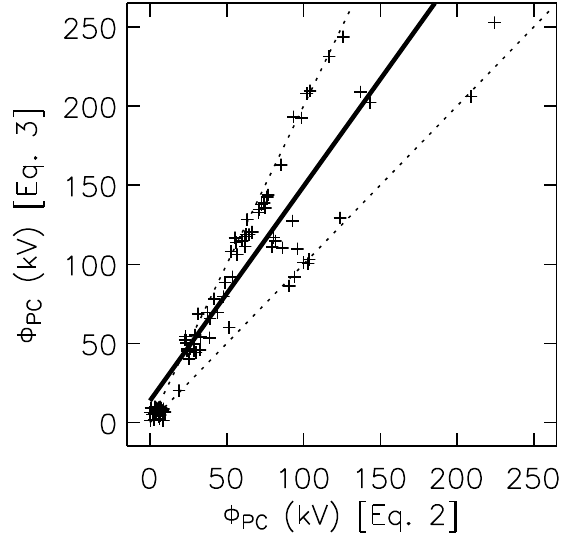
Fig. 3. A comparison of estimates of 8 PC from Eqs. (2) and (3). Dotted curves show the lines of 8 0 The full curve shows the least-squares line of best fit.